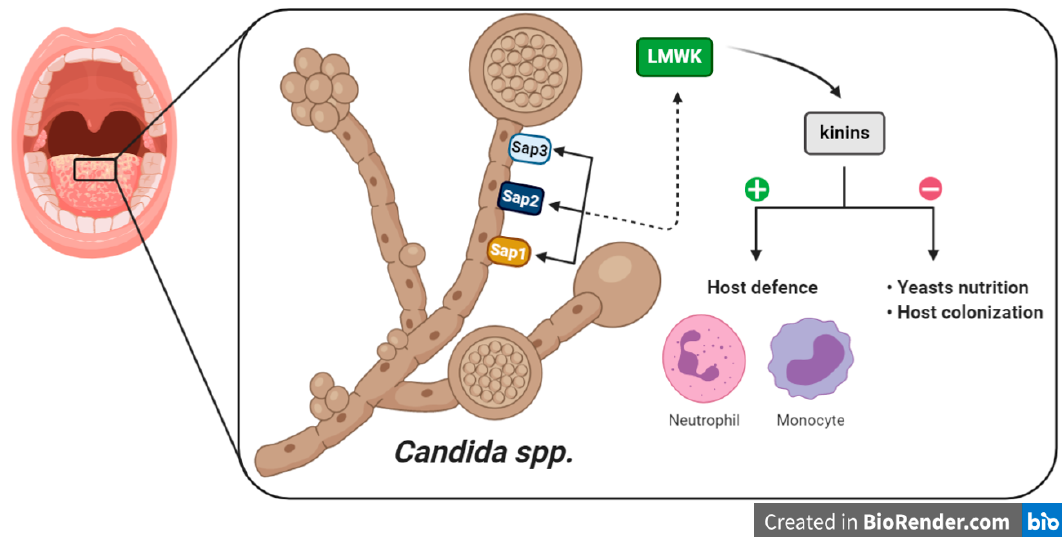
Figure 4. Involvement of kinin system in candidiasis. The pathogenicity of Candida spp. in sequential stages of interaction (Sap -> LMWK -> kinins -> effects) with kinin signaling in human host infection. Sap = secreted aspartic protease; LMWK = low molecular weight kininogen.